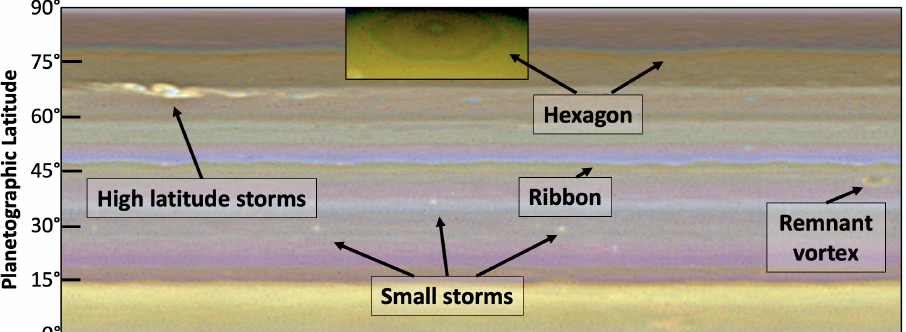
Figure 7. Saturn’s major northern hemisphere cloud features in Hubble WFC3 data from June 2018. Individual latitude bands have slightly different colors in this contrast- and sharpness-enhanced map over ∼ 180 ◦ of longitude; 1 ◦ of longitude = ∼ 10,500 km at the equator. The small vortex near 40 ◦ is a remnant of the large 2010 storm, and small thunderstorm-like clouds are visible at mid latitudes. Inset: The polar hexagon (unmapped) was prominent in 2018, and the boundaries varied at different wavelengths, giving it a multi-colored